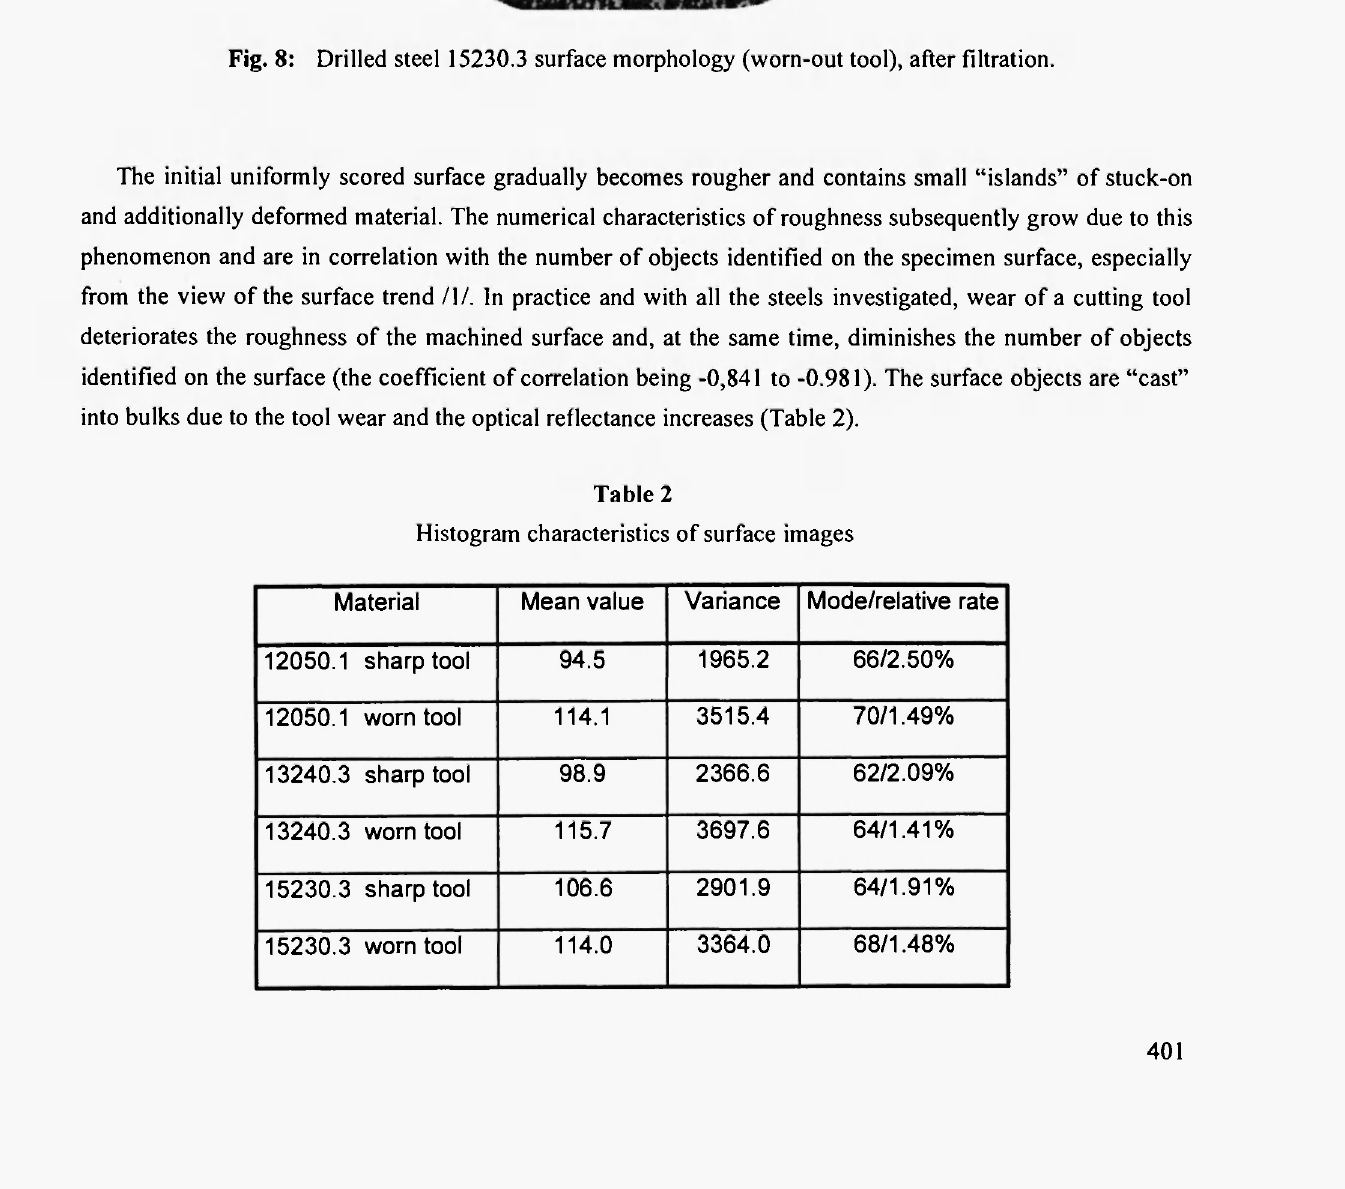
Fig. 8: Drilled steel 15230.3 surface morphology (worn-out tool), after filtration.